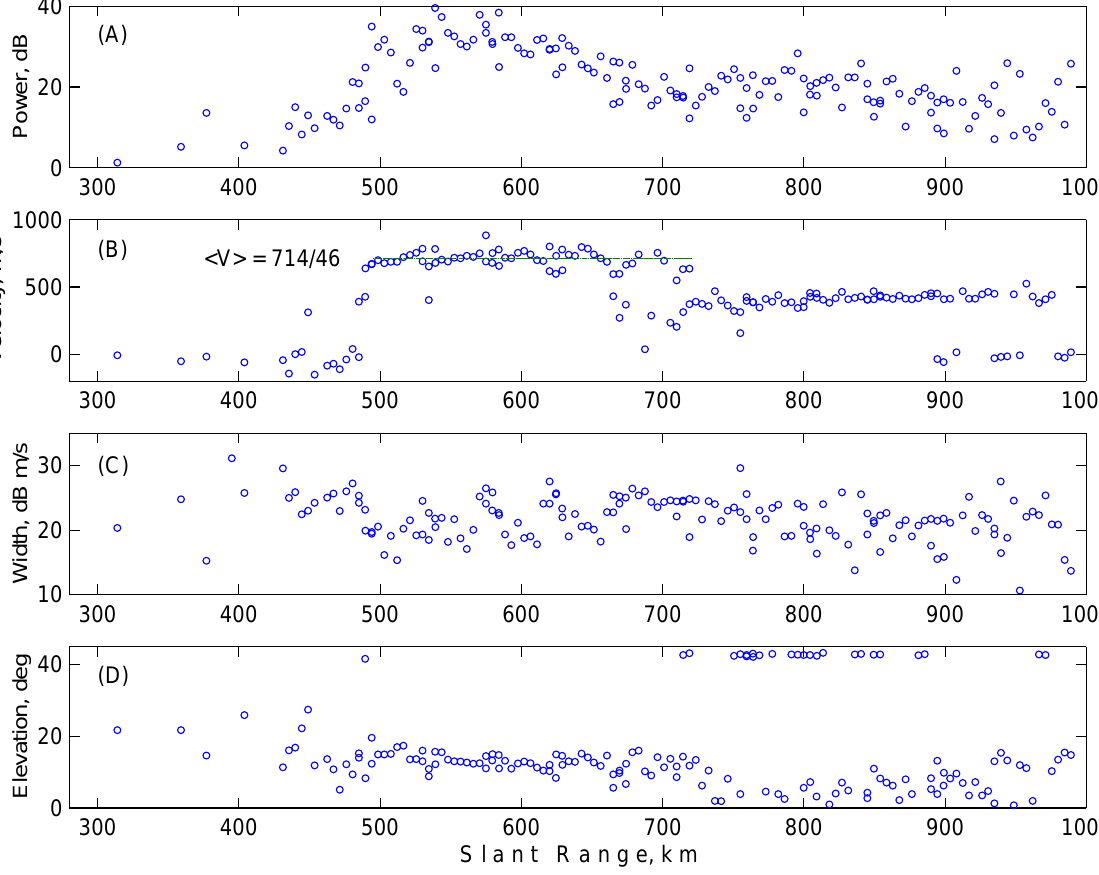
spectral width. Note that the spectral width is presented in Fig. 6c in a logarithmic scale to better resolve changes of nearly two orders of magnitude in a span of the